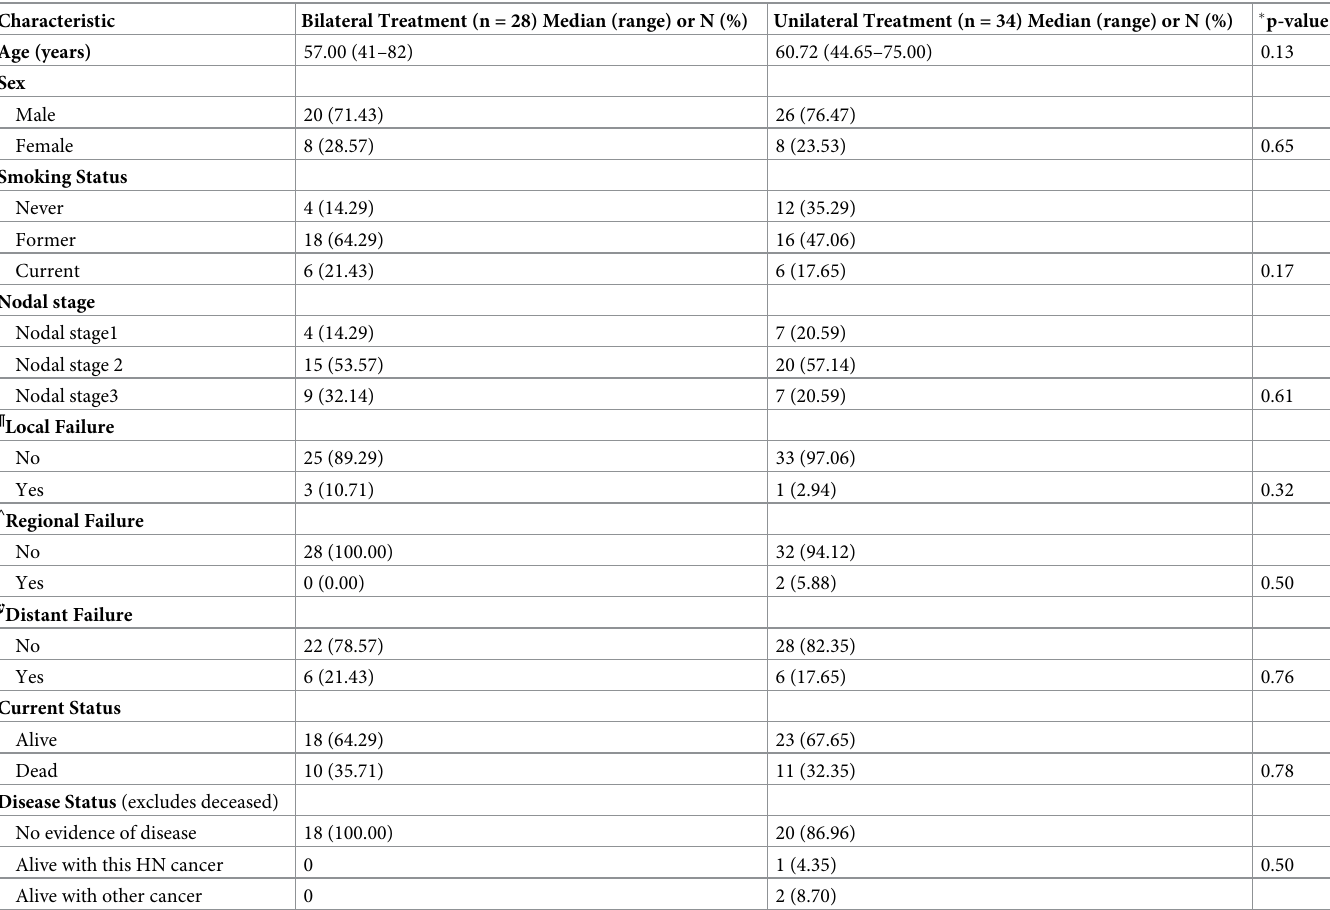
Table 2. Characteristics of unilaterally and bilaterally treated patients with squamous cell carcinoma of the head and neck from an unknown primary (n = 62). Characteristic